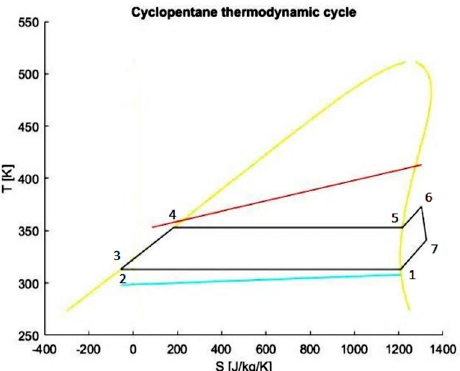
Figure 3. Cyclopentane T – S diagram. Table 1. Cyclopentane thermodynamic parameters.